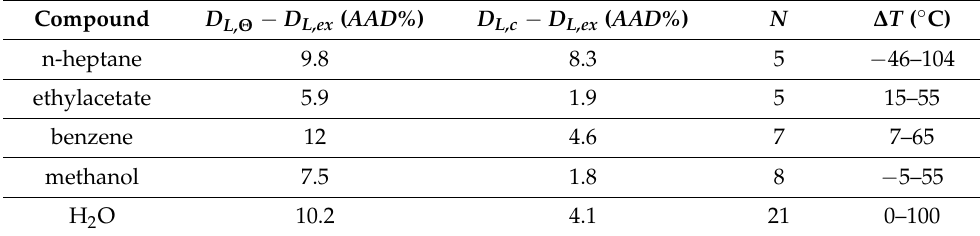
Table 7. Comparison of self-diffusion coefficients D L, Θ = 1.25/ η L · 10 8 , D L,c calculated with Equation (25) and experimental values, and D L,ex for 4 organic compounds with different polarities from N data in the temperature range ∆ T . For water, 21 data with D L, Θ = 2.2/ η L · 10 8 are given.